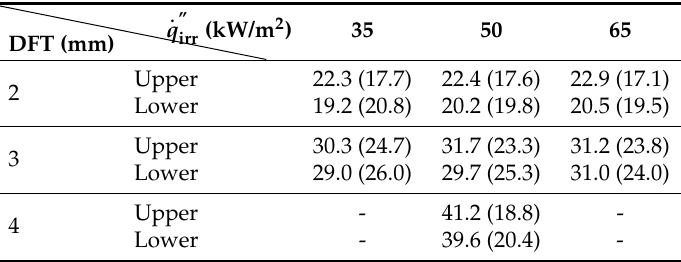
Table 2. Experimental data of fully expanded thickness (units of mm) [14].